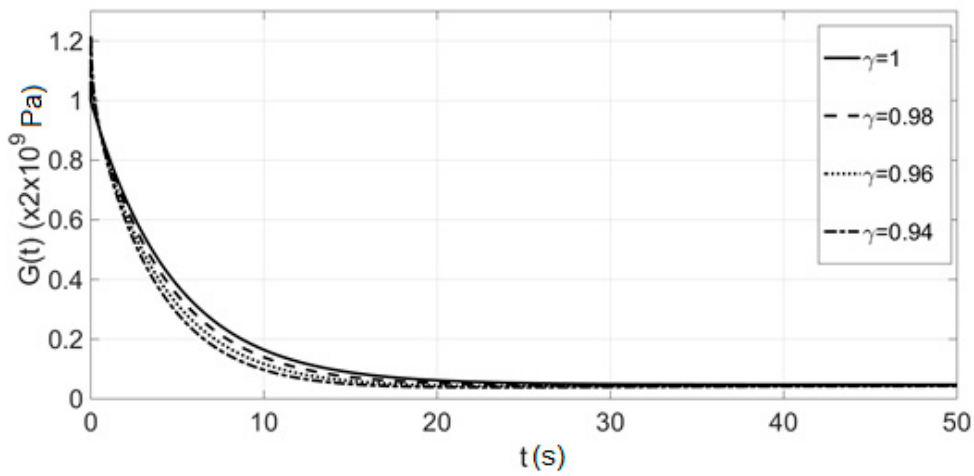
Figure 11. Variation of the relaxation modulus versus time for γ = 1, 0.98, 0.96, 0.94 in the initial space.